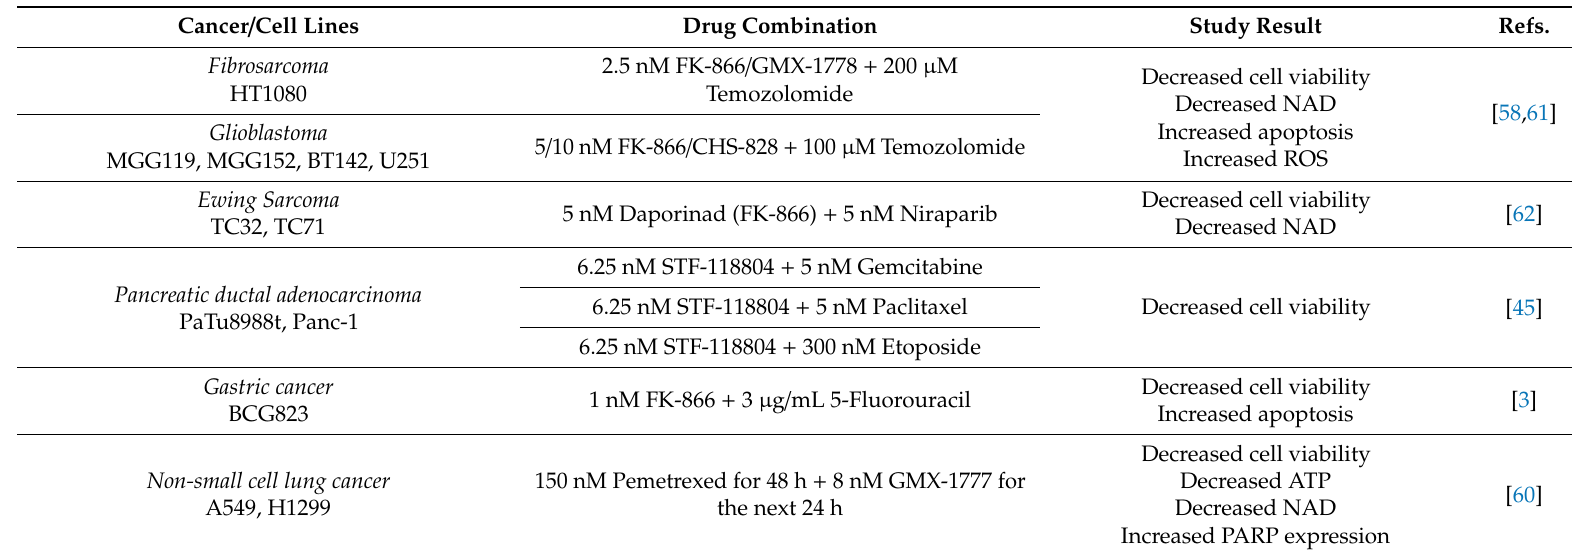
Table 2. Performance of NAMPT inhibitor in combination in